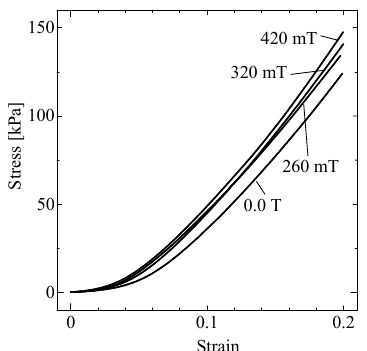
Figure 4. Stress-strain curve for MREs. Both stress and strain represent “engineering” stress and strain. Positive strains correspond to compression strains.